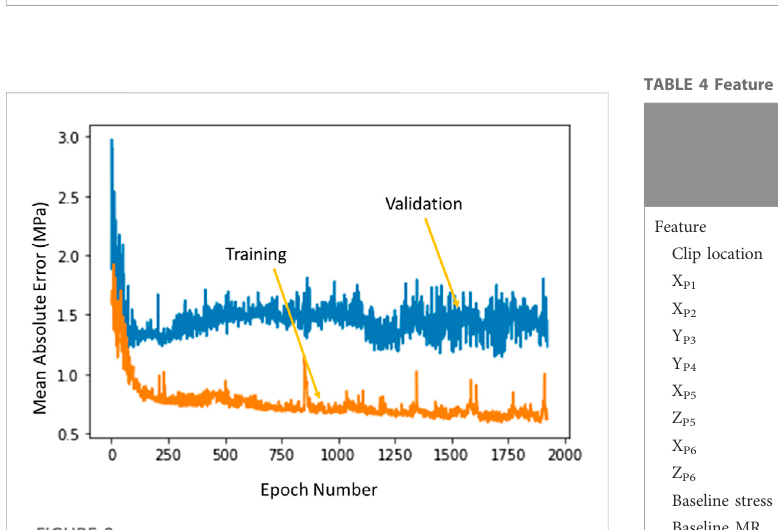
FIGURE 8 The training error and test error change with number of epochs in DL algorithm. The XGBoost errors have a similar behavior. Python (3.7, https://www.python.org/) was used to create this fi gure.